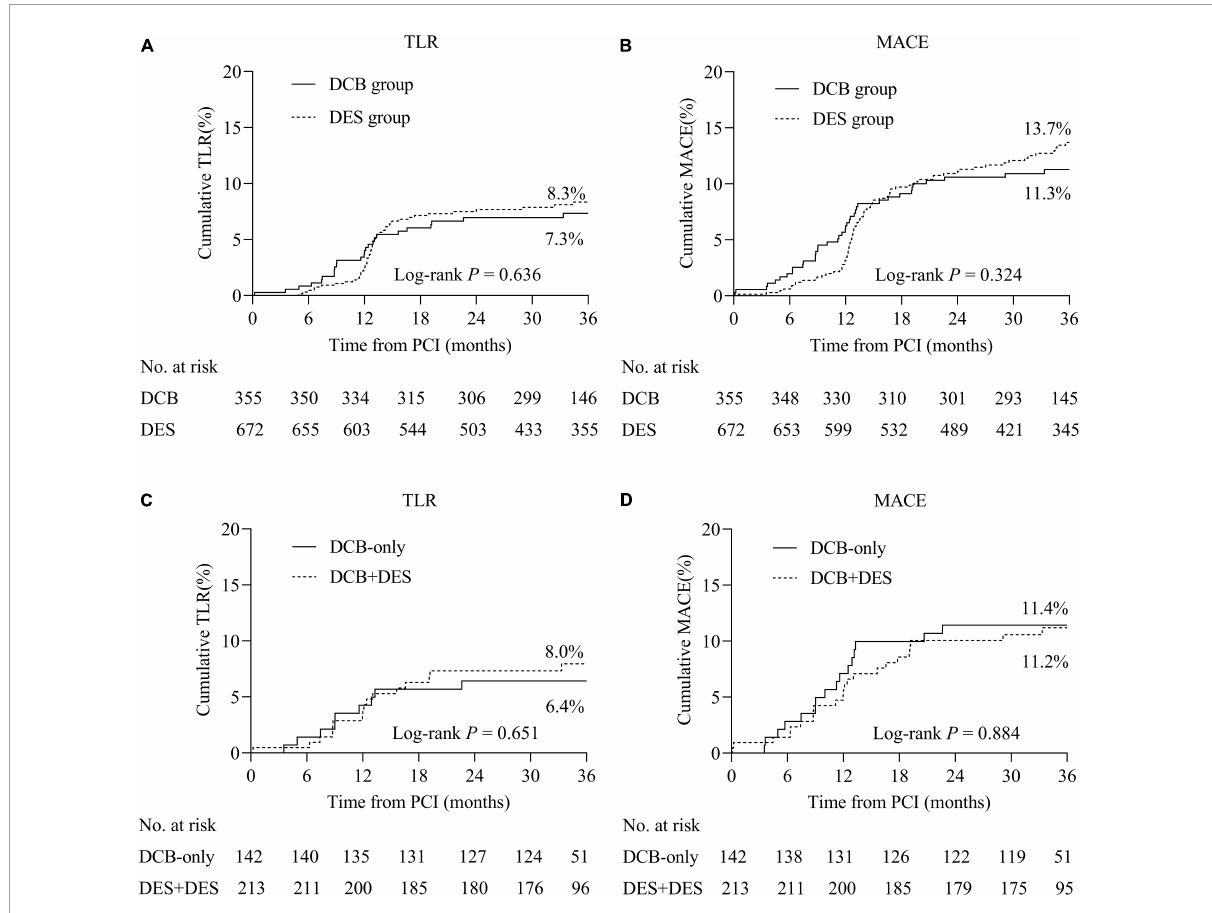
FIGURE2 Cumulative incidence rates of primary and secondary outcomes. (A) TLR between the DCB and DES groups. (B) MACE between the DCB and DES groups. (C) TLR between the DCB-only and hybrid strategies. (D) MACE between the DCB-only and hybrid strategies. TLR, target lesion revascularization; MACE, major adverse cardiac